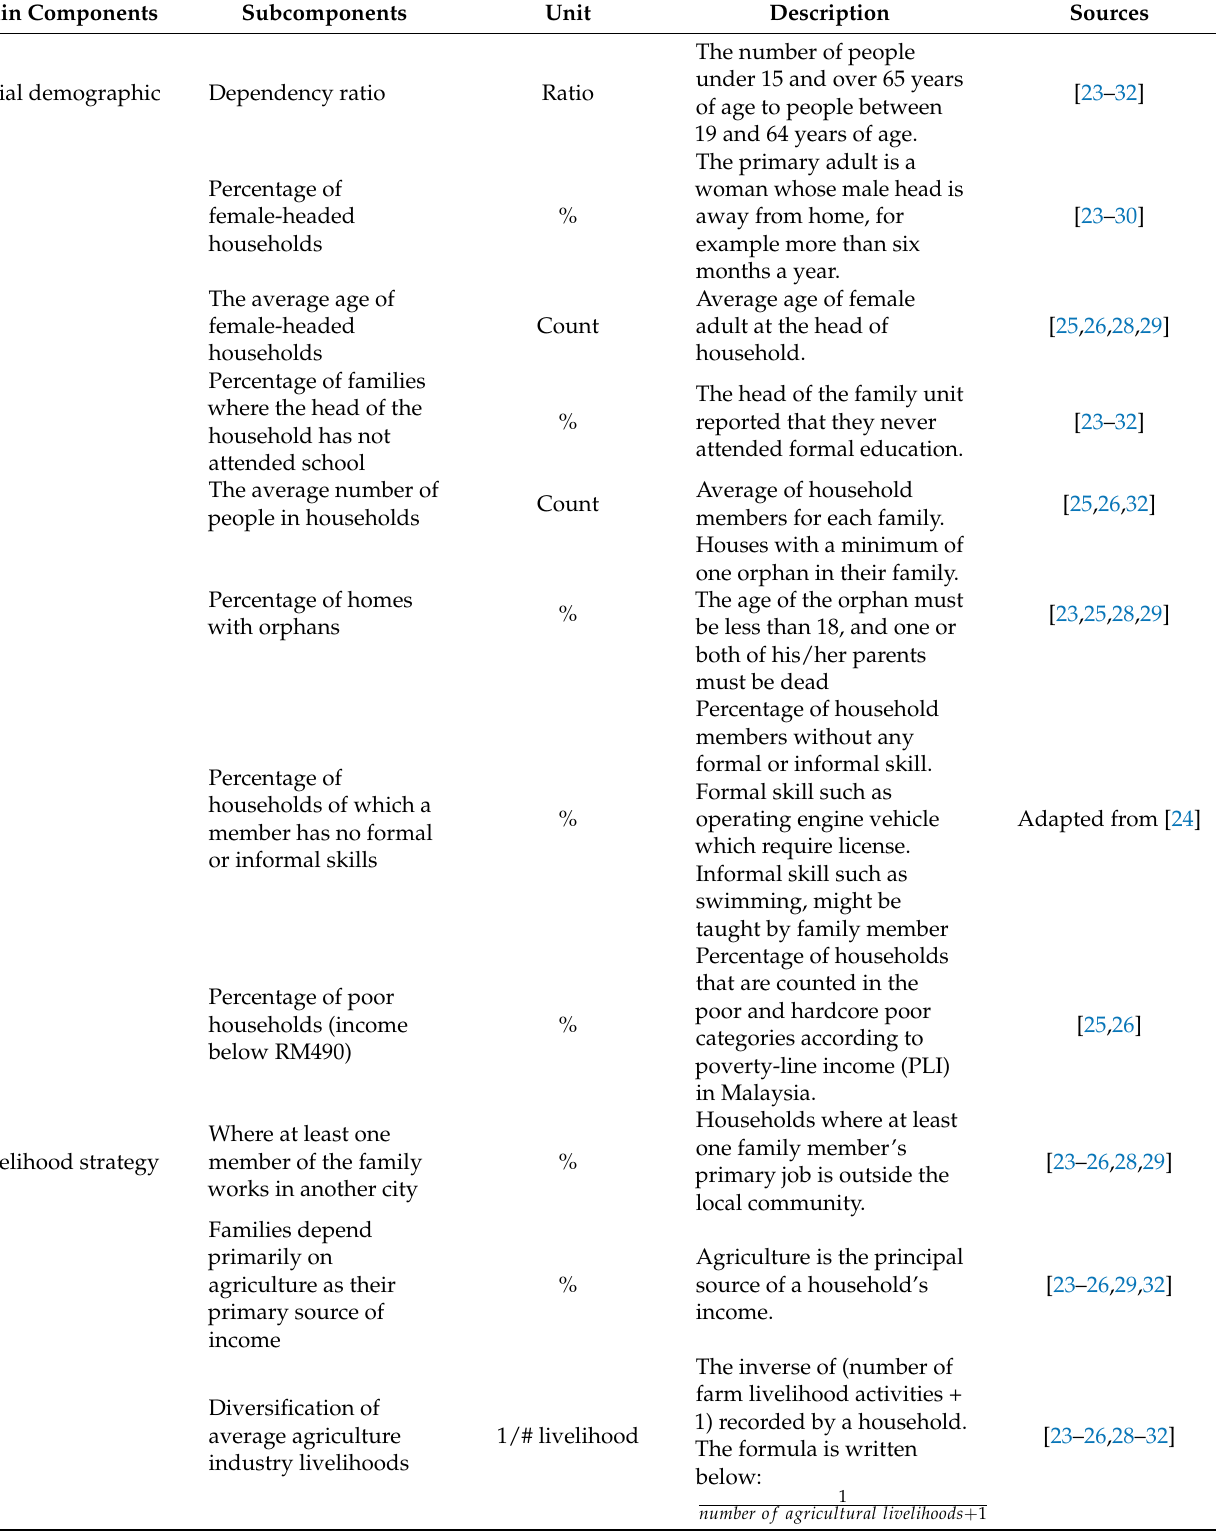
Table 1. Livelihood vulnerability index (LVI) of principal components and